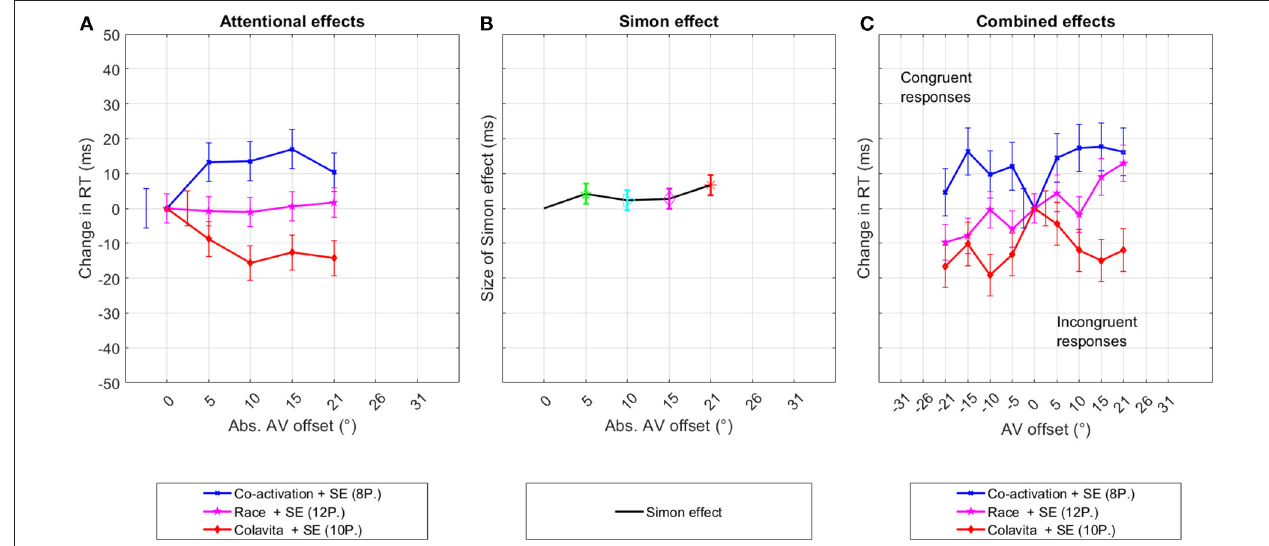
FIGURE 8 | Experiment two—multi-talker speech interference. This figure shows the decomposition of the original RT distribution into the underlying even and odd components per participant group that were possibly caused by changes in the spatial attention and the Simon effect. The third graph depicts the original distribution of the data sorted into congruent and incongruent responses. The graphs show the changes in mean RTs between data from 0 ◦ and data at offset in (A,C) , and as the difference in RTs between congruent and incongruent responses (B) . The bars indicate the standard